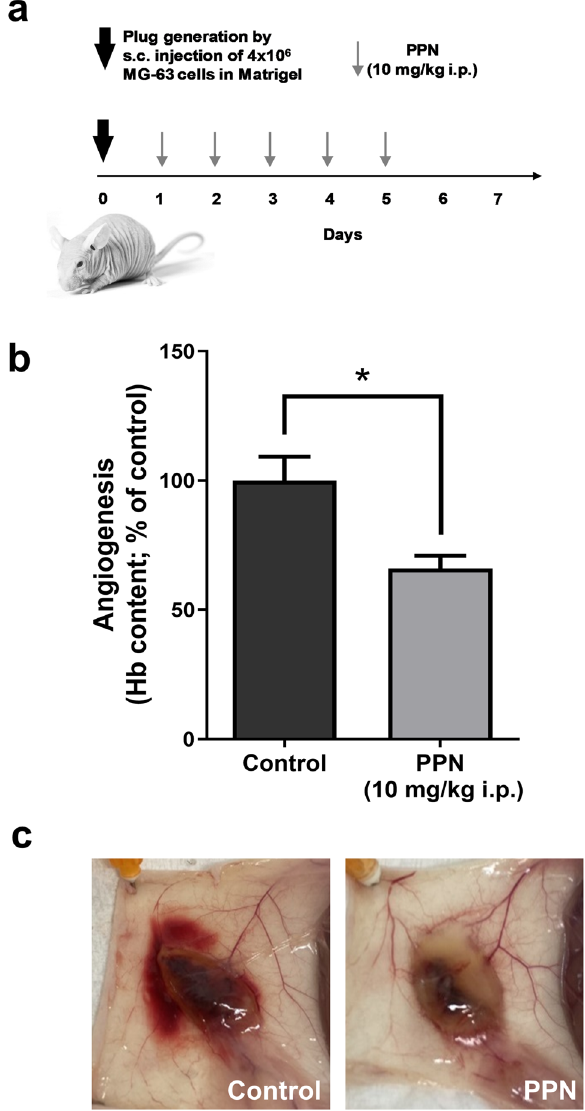
Figure 4. Propranolol treatment inhibits osteosarcoma-driven angiogenesis. Impact of propranolol (PPN) administration (10 mg/kg/day, i.p.) on MG-63-induced angiogenesis was assessed using a modified-Matrigel plug assay in nude mice. ( a ) Experimental design and PPN dosing. ( b ) Early angiogenic response was assessed by quantification of hemoglobin content in the recovered Matrigel plugs using the Drabkin’s method (see "Methods" section). ( c ) Representative photographs of subcutaneous vascularized implants in vehicle or PPN- treated animals. Five animals per experimental group. Data are presented as mean ± SEM. * p < 0.05, unpaired t